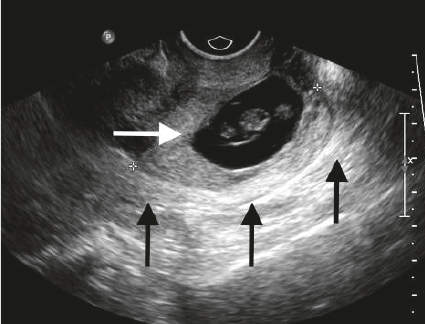
Figure 1: Transvaginal ultrasound showing a live ectopic pregnancy (white arrow) in the posterior wall of the cervix (black arrows). FHR 174 pbm. Estimated fetal age was 8 weeks, 1 day.